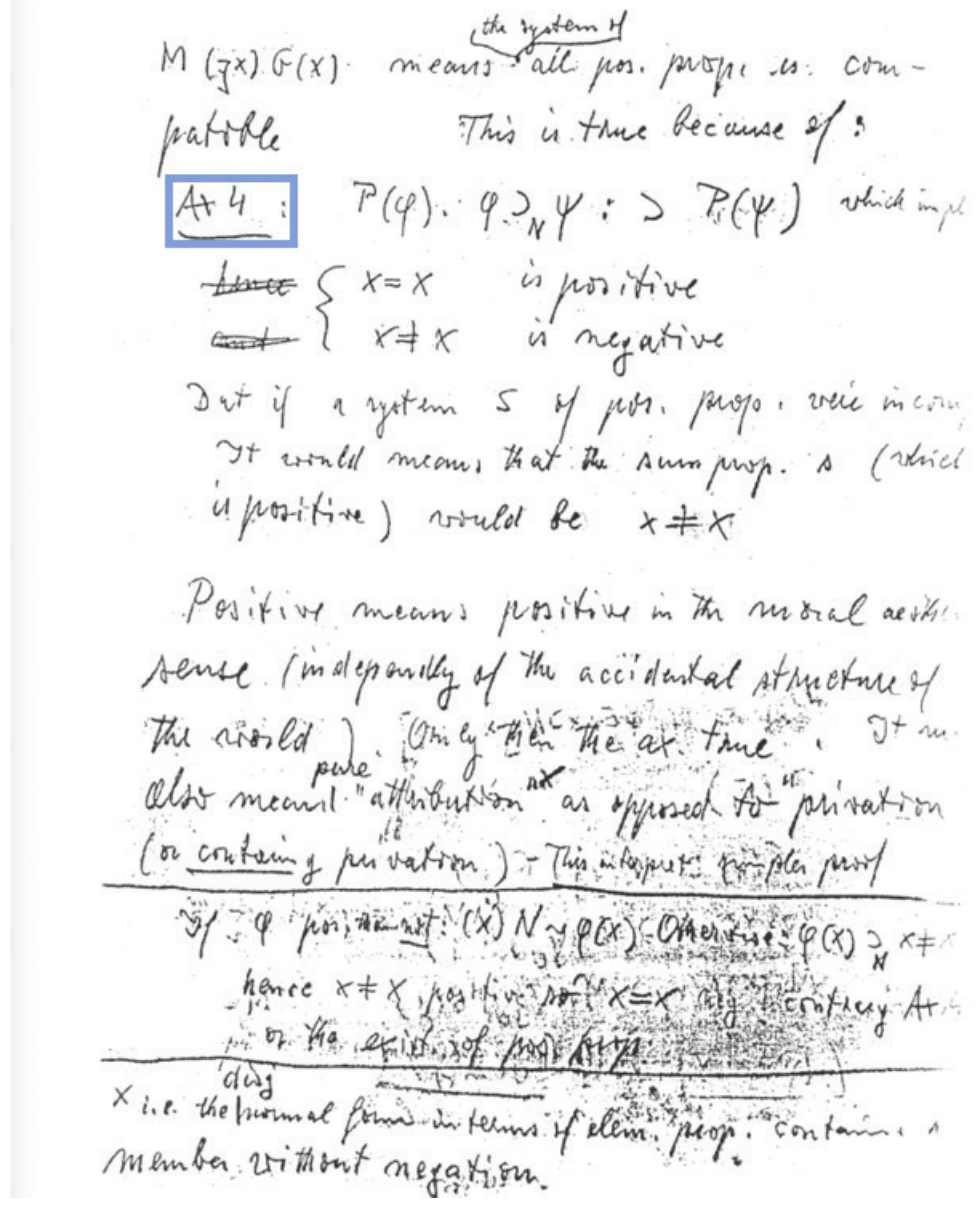
Figure 2: Page 2 of Gödel's Manuscript. The axioms causing the inconsistency in Gödel's modal logic variant of the ontologi- cal argument for the existence of God are highlighted (by us) in blue. (Unpublished works of Kurt Gödel are Copyright Institute for Advanced Study and are used with permission. All rights reserved by Institute for Advanced